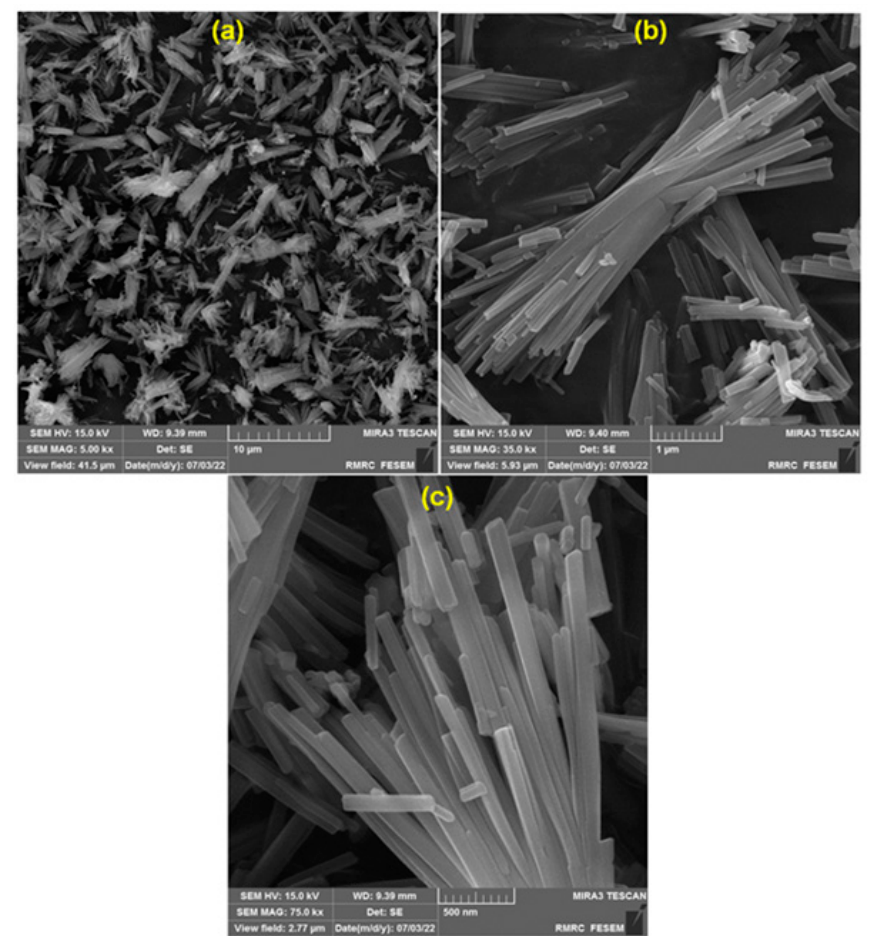
Figure 4. FE-SEM images of sheaf-like Ce-BTC MOF nanostructures at different magnifications ( a ) 5’000, ( b ) 35’000, and ( c ) 75’000.